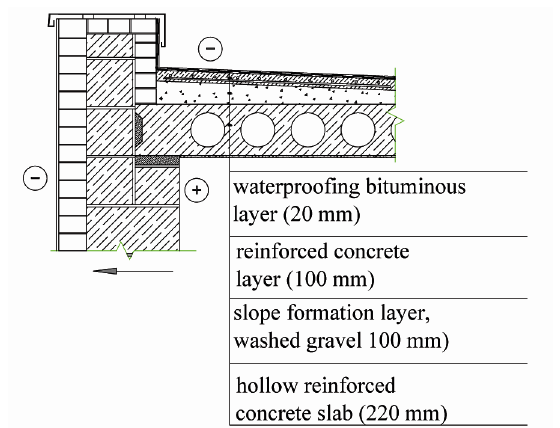
Fig. 2. Cross section of the roof before renovation. The roof detail consists of a hollow concrete slab, sand, and a waterproof bituminous